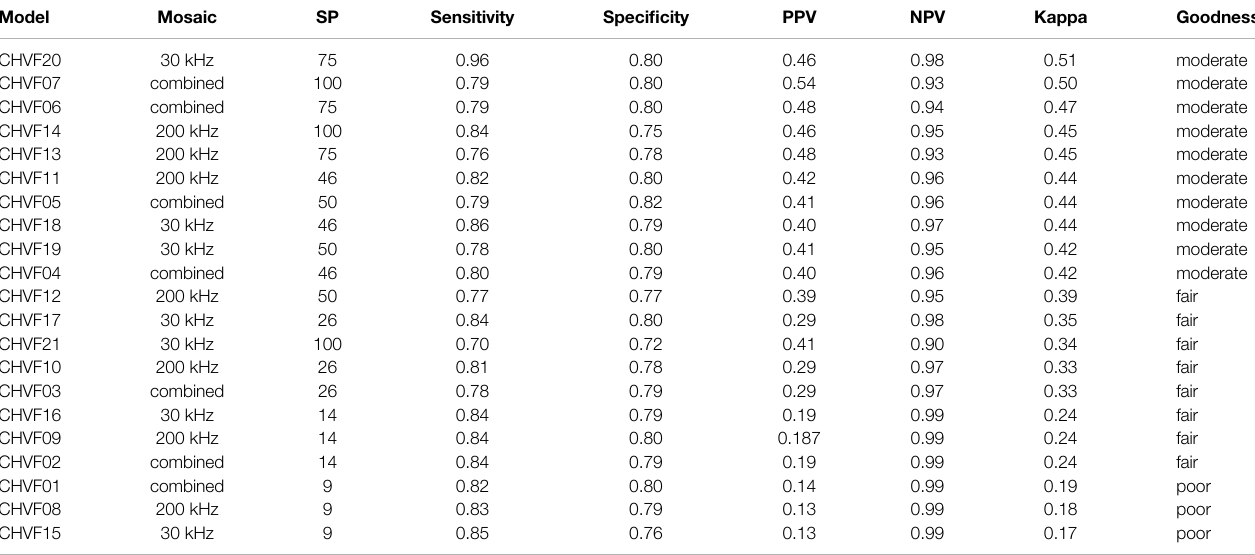
( Figure 9 .9) or rocky piles of hardgrounds ( Figure 9 .10); occasional anemone gardens ( Figure 9 .9) and mussel beds ( Figure 9 .10); areas of extensive white fi lamentous bacterial mats with very-high- fl ux gas and liquid expulsion ( Figure 9 .11). Of note were the many instances of liquid and gas bubble expulsion at the same area of seabed, with one high fl ux gas and fl uid expulsion area of rocky substrate blanketed by thick white bacterial mats ( Figure 9 .12). These hardground regions coincided with very-high backscatter intensity in both mosaics. Other very-high backscatter intensity patches in the South Calypso HVF survey area were not sampled with the towed camera. FOI-03 in the North Calypso HVF ( Figures 8E,F ), hosts fl uid expulsion coinciding with a broad break of slope ( Figure 1B ). This sea fl oor was characterized by: bioturbated sedimented regions with no fl uid expulsion ( Figure 9 .13); white and lilac colored fi lamentous bacterial with and without gas bubble expulsion ( Figure 9 .14), with lilac colored bacteria corresponding with areas of minimal fl uid expulsion ( Figure 9 .15); ∼ 0.5 m diameter anhydrite mounds with high fl ux liquid expulsion (observed in towed camera footage as shimmery fi lm) ( Figure 9 .16); hardground regions with lower fl ux gas bubble expulsion, from the perimeters of, or in between, broken platforms ( Figure 9 .17) and rocky piles of hardgrounds; and occasional anemone gardens ( Figure 9 .18). Here, hardground areas corresponded to very-high backscatter intensity in the 30 kHz mosaic and also in the 200 kHz mosaic, though the overall very-high intensity signal of the 200 kHz mosaic obscured direct comparisons between very- high 200 kHz values and sea fl oor observations. More extensive and very-high backscatter intensity patches in the North Calypso HVF survey area were not sampled with the towed camera on this survey.